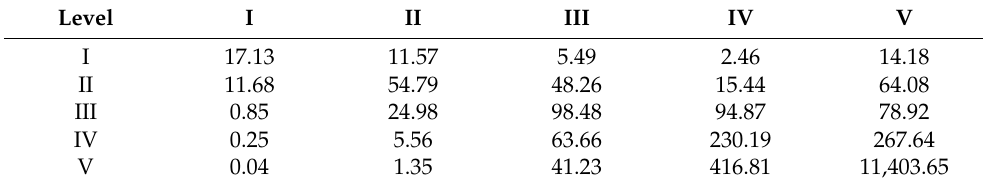
Table 4. Areas (ha) of misclassification of the five coverage levels derived from FVC 30m